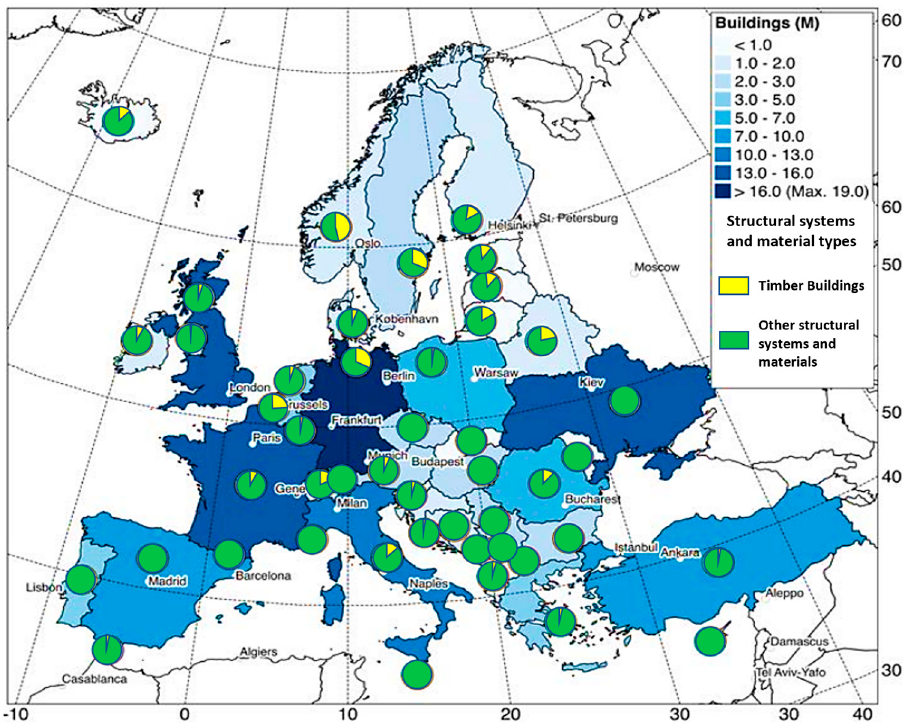
Figure 1. Total number of buildings in the European countries (in millions) and the exposure distribution of timber buildings [5].